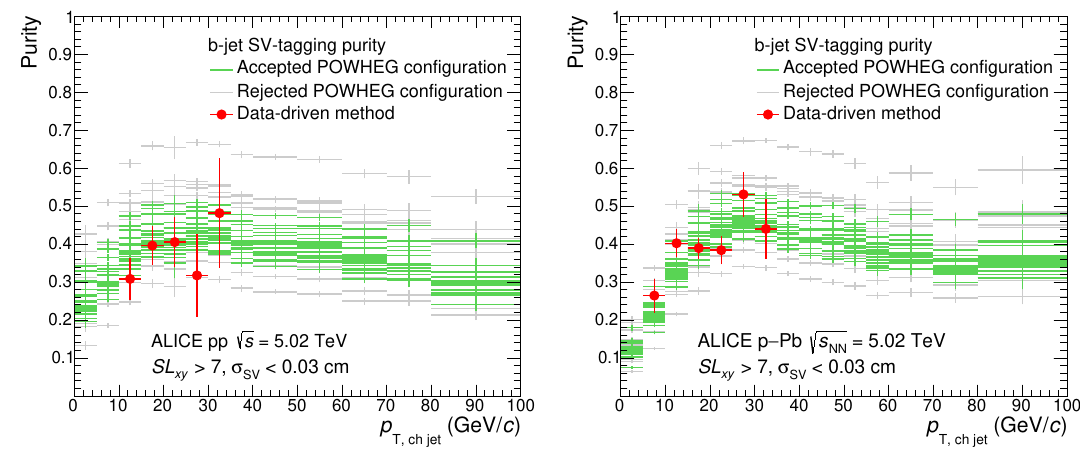
Figure 10. Purity of the b-jet candidates selected with the SV method when using the default tagging selection criteria. The purity was estimated with the data-driven template fit method (red points) and with the POWHEG-simulation based approach. The POWHEG scale variations accepted by the statistical analysis are colored green, the rejected ones are gray. Results for pp and p-Pb are shown in the left and right panel,